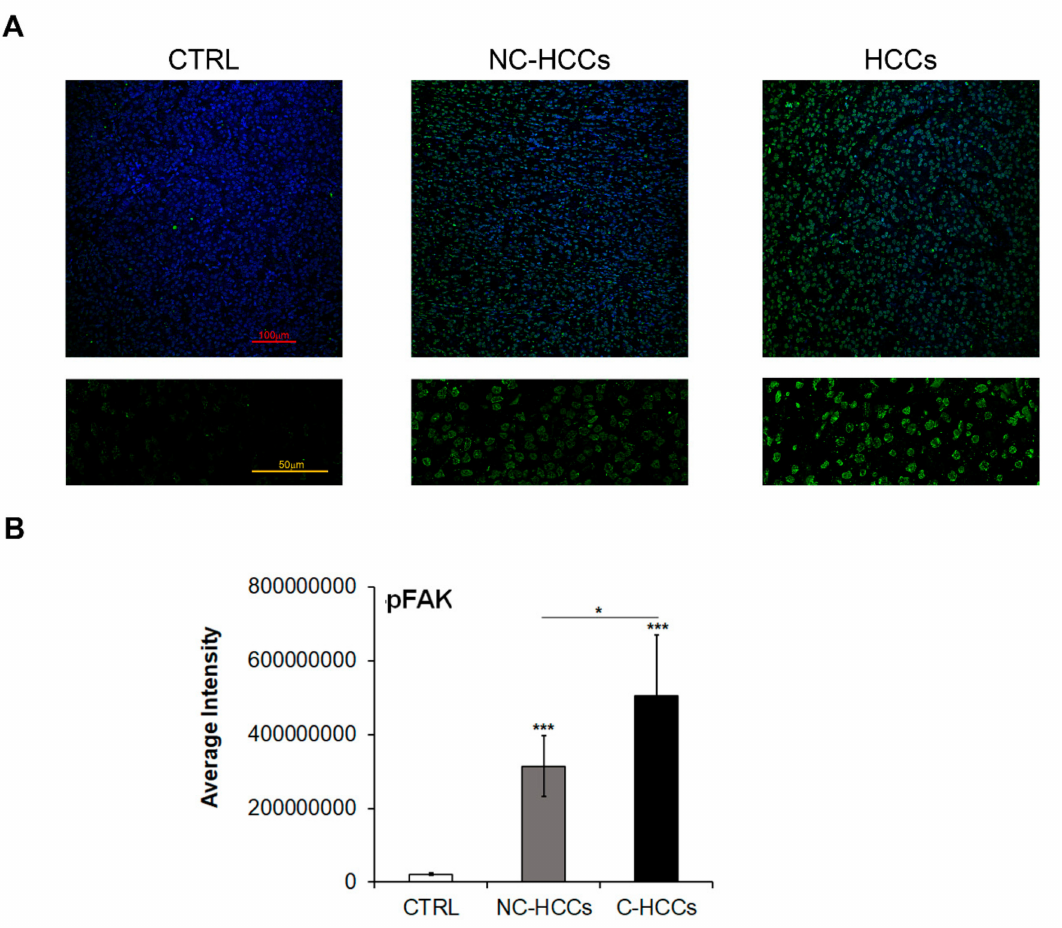
Figure 3. Expression of Y397-pFAK in healthy livers and pediatric HCCs. ( A ) Representative immunofluorescence of FAK healthy livers (CTRL), Non-cirrhotic and cirrhotic pediatric HCCs. 20 × magnification (upper panels); 60 × magnification (lower panels). ( B ) Average fluorescence intensity calculated for Y397-pFAK in CTRL in pediatric HCCs according to cirrhotic (C-HCCs) / non-cirrhotic (NC-HCCs) milieu. (*, p < 0.05; ***, p <